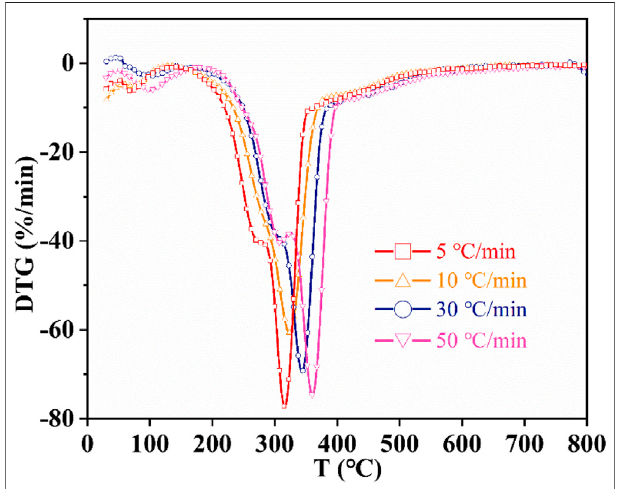
FIGURE 3 | DTG curves of corn straw under different heating rates in nitrogen atmosphere.